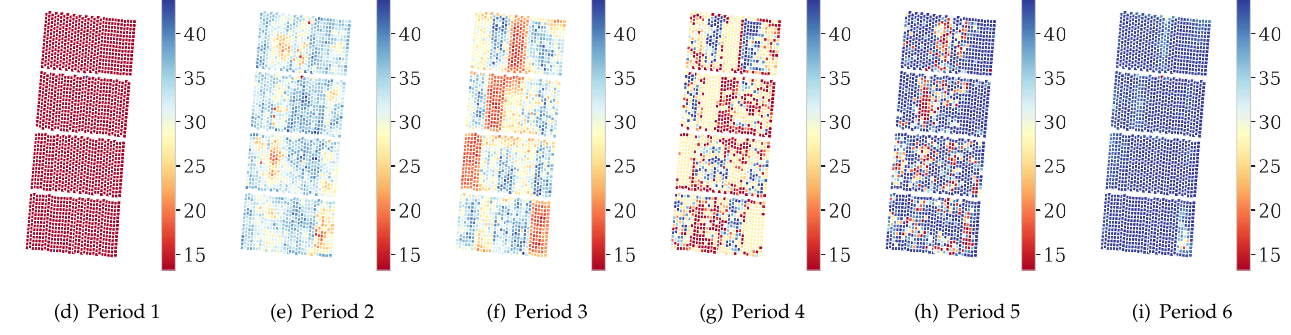
Figure 10. Total biomass predicted using the proposed method for six periods. The color bars denote total biomass estimates from 10 to 40 in unit of